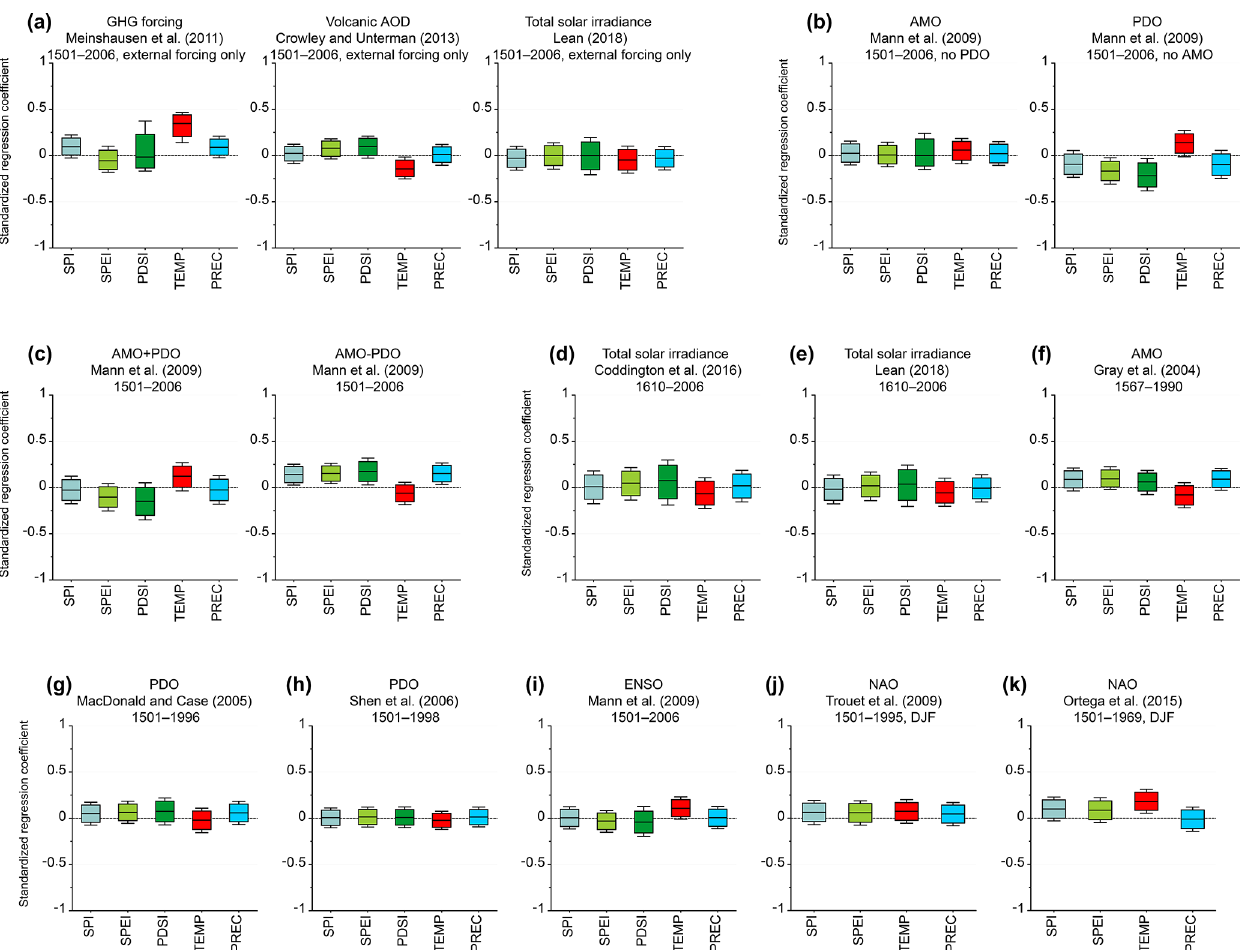
Figure 6. Standardized regression coefficients (central line, with 95% confidence interval shown as the box and 99% confidence interval as the whiskers), obtained by multiple linear regression between the predictands characterizing local Czech climate (drought indices, tempera- ture and precipitation) and (a) a set of explanatory variables representing external forcings only (i.e., a three-predictor setup involving GHG forcing, volcanic aerosol optical depth and total solar irradiance only), (b) a setup from Fig. 4 with only AMO or only PDO predictor instead of both, (c) a setup from Fig. 4 with AMO and PDO predictors replaced by their mean (AMO + PDO) and difference (AMO − PDO), and (d–k) setups with one of the predictors replaced by its alternative version while keeping the rest the same as in Fig. 4 (only coefficients for the modified predictors are